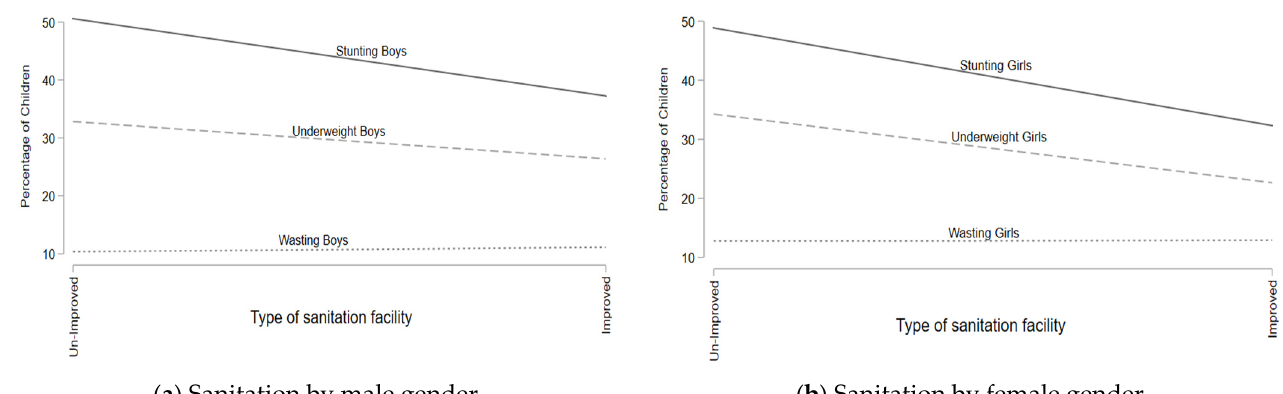
Figure 2. Prevalence rates of wasting, stunting, and being underweight for sanitation facility (dis- aggregated by child gender).